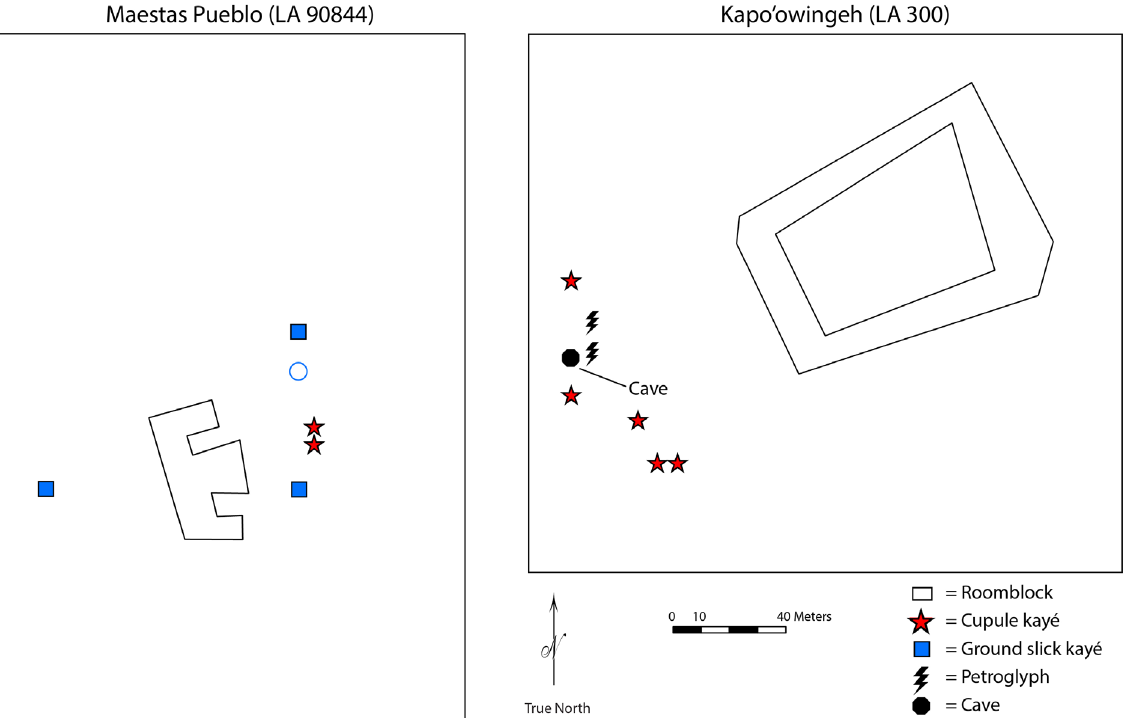
Figure 5. Kayé with cupules, and associated landscape features, at the Late Coalition period sites of Maestas Pueblo and Kapo’owingeh. [NOTE (23 JUNE 2017): This figure has been modified at the request of the